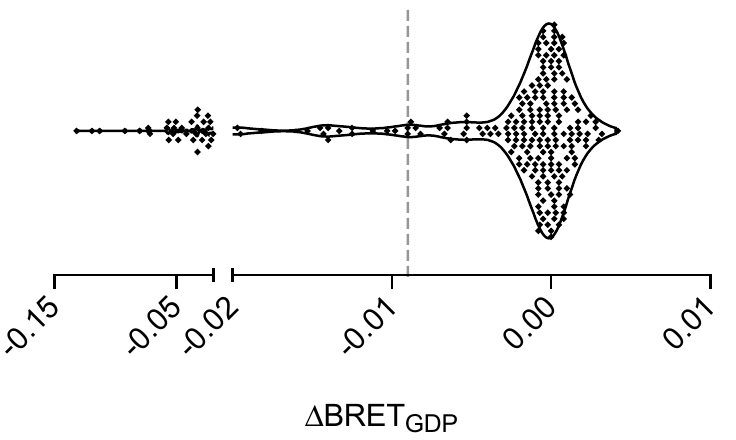
Fig 2. Determination of threshold Δ BRET GDP . Most receptor-G protein pairs did not interact, and values of Δ BRET GDP were distributed around zero. Values to the left of the dashed vertical line ( Δ BRET GDP = -0.009) were identified as outliers from this background distribution (i.e. coupled pairs) with a false discovery rate (FDR) of 1%. Each point represents a single receptor-G protein pair, and the mean of three independent experiments performed in duplicate.